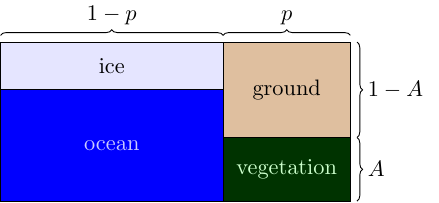
Figure 1. Schematic representation of the model planet’s surface, including a fraction p of land and 1 − p of ocean. The fraction of the ocean that is covered by sea ice depends on the global tempera- ture T , while the land is covered by a fraction A of vegetation.